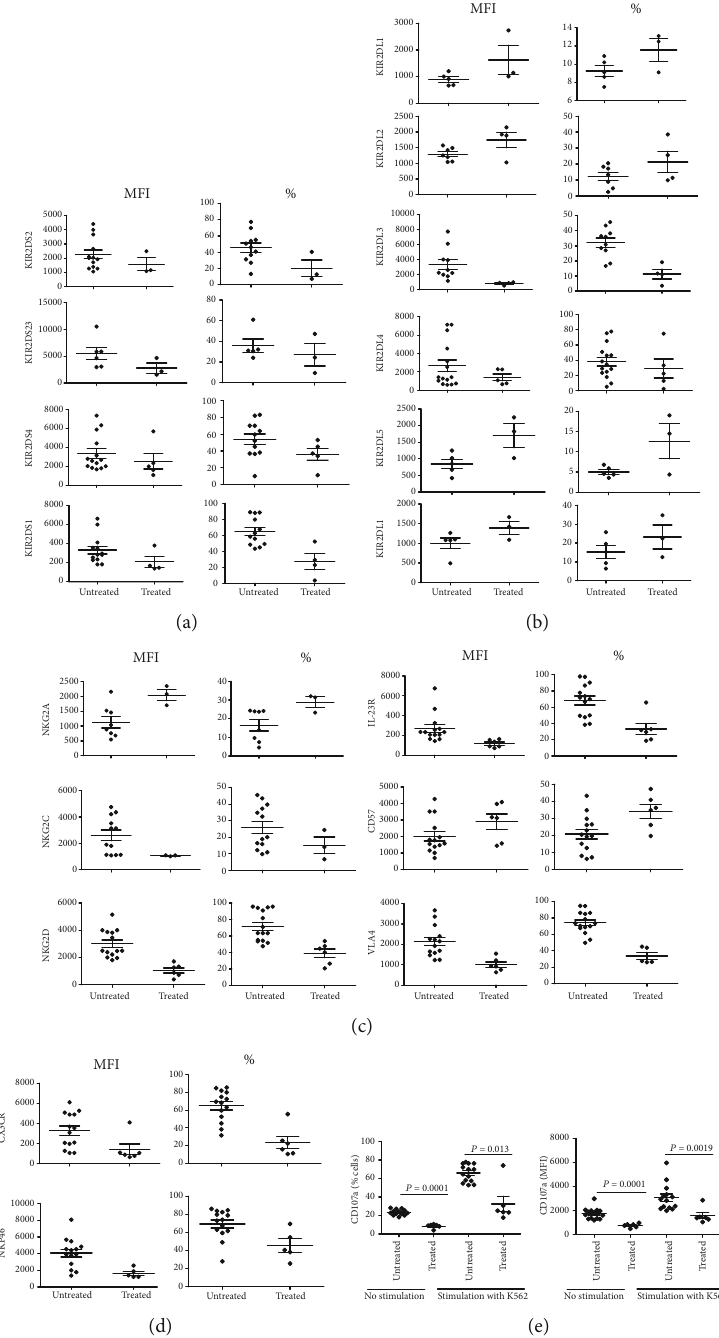
Figure 8: Comparison of NK cell expression of di ff erent parameters between treatment-naïve (untreated) and under-treatment (treated) CD patients. The fi gure shows NK cell expression of activating KIR (a), inhibitory KIR (b), non-KIR receptors and VLA-4 (c), NKP46 and CX3CR1 (d), and CD107a with and without stimulation with K562 cells (e). This fi gure shows means ± SE and p